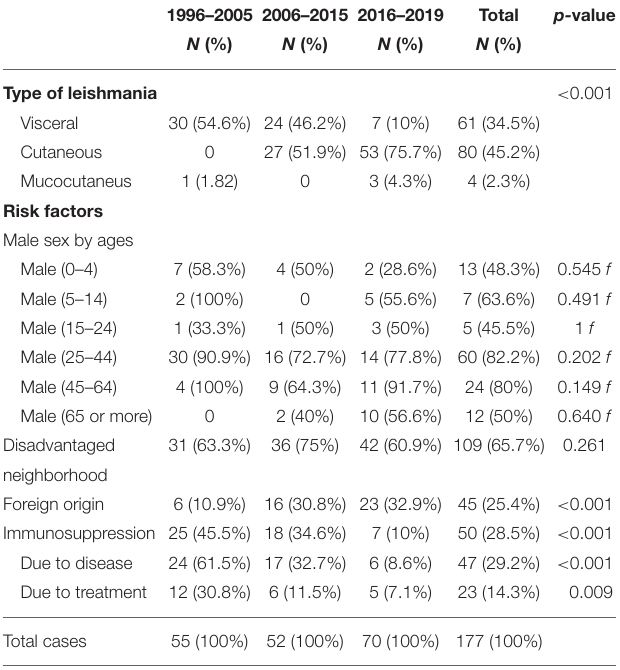
TABLE 3 | Cases of leishmaniasis according to type of disease and risk factors, during the three studied